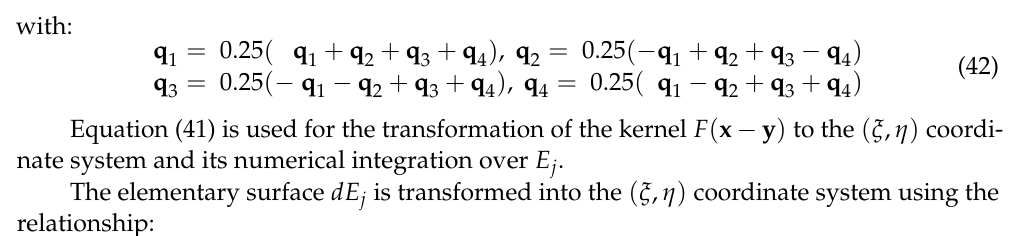
and the normal vector j